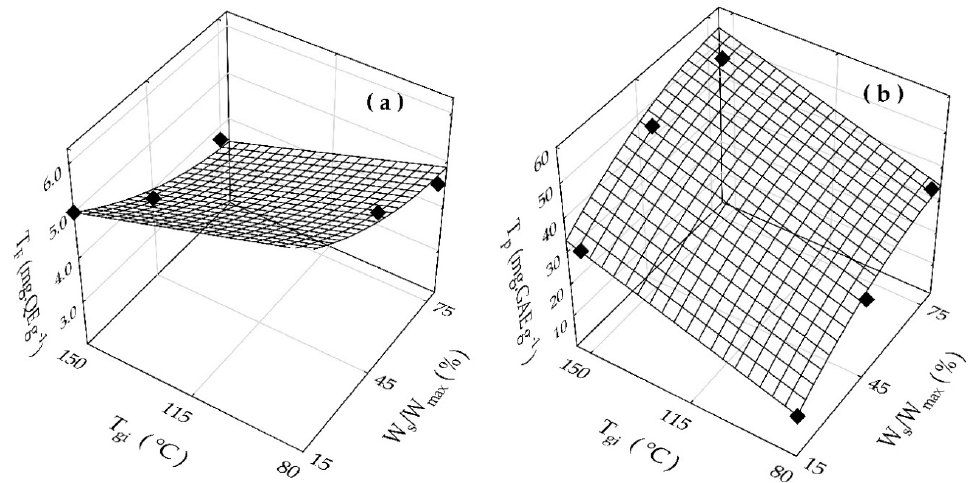
Figure 1. Response surface plots showing the effects of drying variables W s /W max and T gi on total flavonoids ( a ), and total polyphenols content in the dried rosemary extract ( b ).